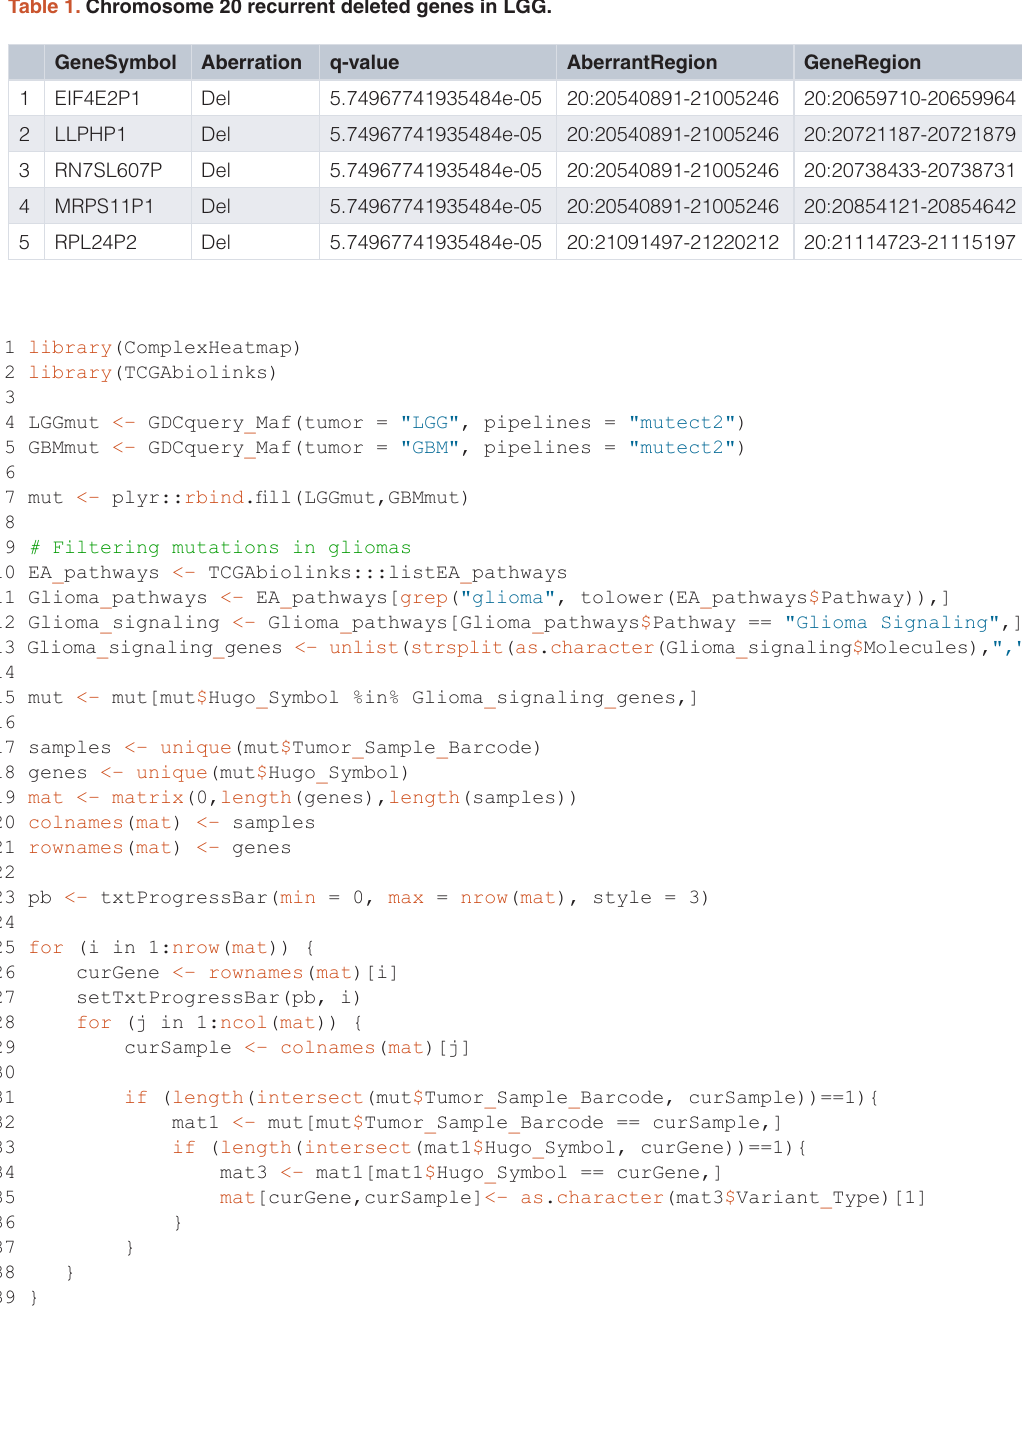
Table 1. Chromosome 20 recurrent deleted genes in